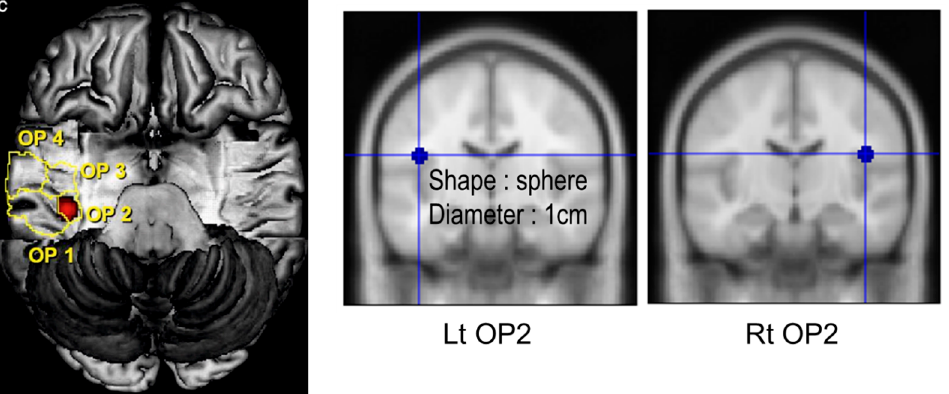
Figure 2. Region of interest for grey-matter volume. Abbreviation: OP, parietal operculum. OP2 is a cytoarchitectonic area located in the posterior parietal operculum, and its volume was measured according to the gray–white-matter ratio. Red and blue dot, Parietal operculum 2.